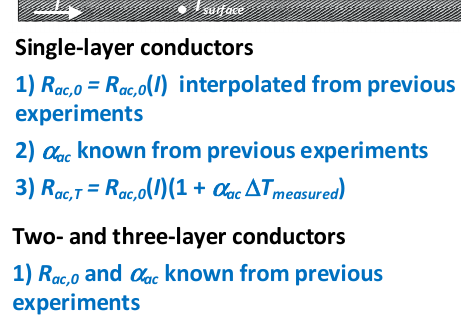
Figure 7. Proposed strategies to measure the AC resistance of the conductor as a function of the temperature and current level.